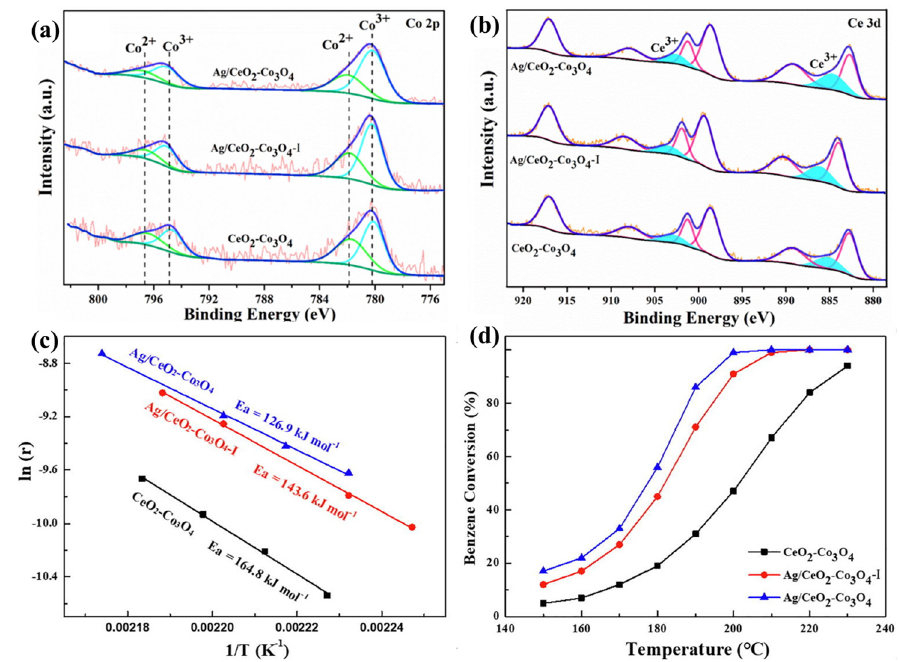
Figure 2. Benzene oxidation characteristics of Ag-based catalysts: XPS profiles of ( a ) Co 2+ /Co 3+ and ( b ) Ce 3+ . ( c ) Arrhenius plot of prepared site, and ( d ) conversion of benzene. Reprinted with permission from ref. [45]. Copyright 2021 Elsevier.